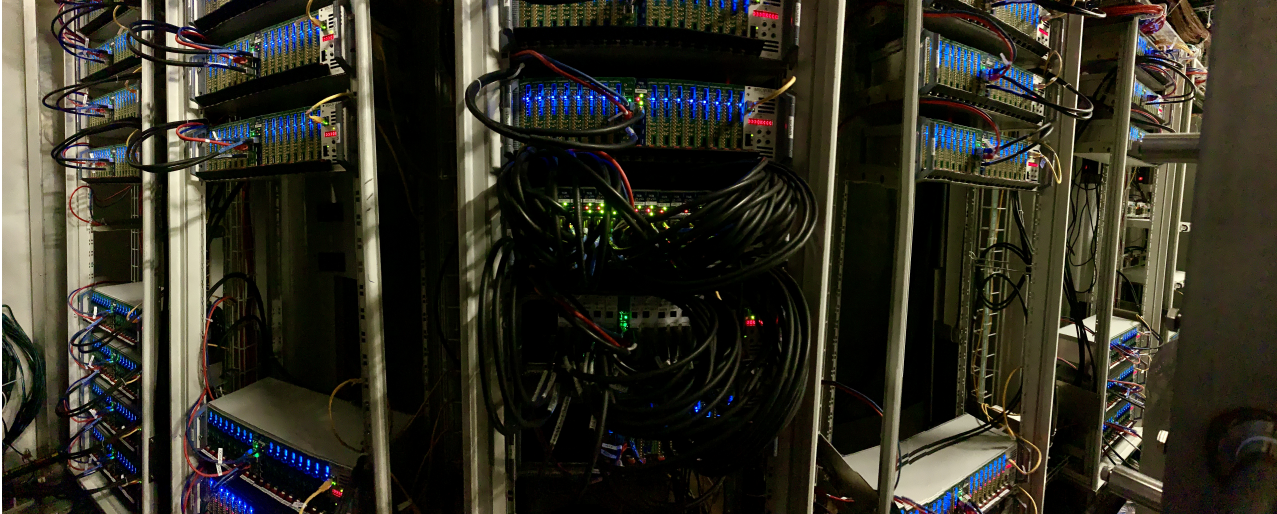
Figure 6. Panoramic picture of the TDAQ system completely installed in the experimental hall. Blue LEDs are from WaveDREAM cards, the different boards in the middle of each crate are DCBs (on the left ) and TCBs (on the right ). The two central crates with black cables are the ones used for trigger generation and